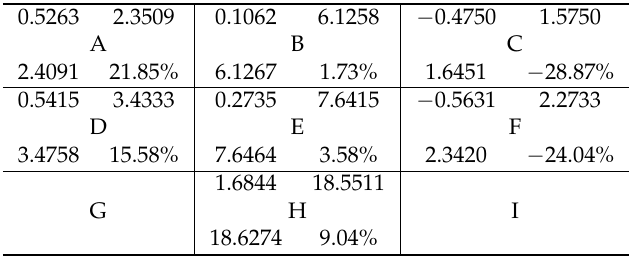
Table 3. Velocity components for loose initial packing density presented for seven zones, from A-F and H (Zones G and I show no results for the loose condition since they were outside the funnel). Each quadrant presents Vx, Vy, Vt, or Vp, clockwise from the upper-left corner. Vx, Vy, and Vt are given in pxpf (pixels per frame).